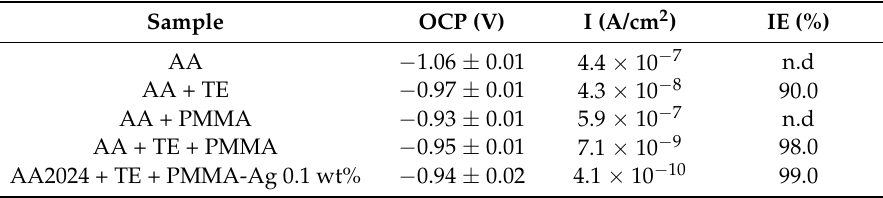
Table 2. Open circuit potential, current, and inhibition efficiency of metal surfaces under different treatments obtained from Figure